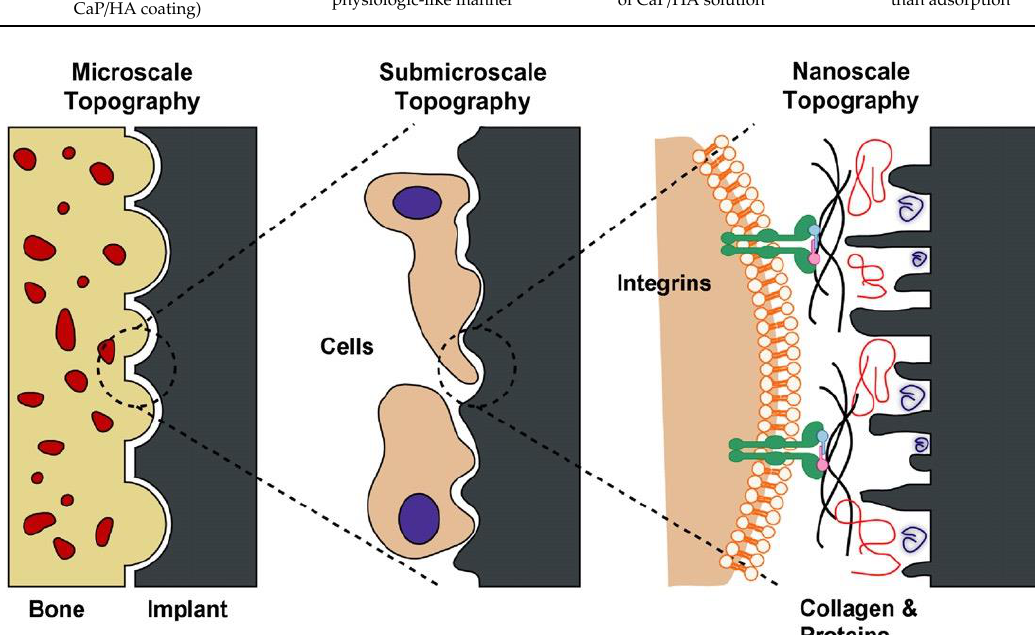
Figure 5. The interaction of bone and implant surface compared at different scales (Gittens et al. [149]); Reprinted with permission from [149]. Copyright 2011 Elsevier.